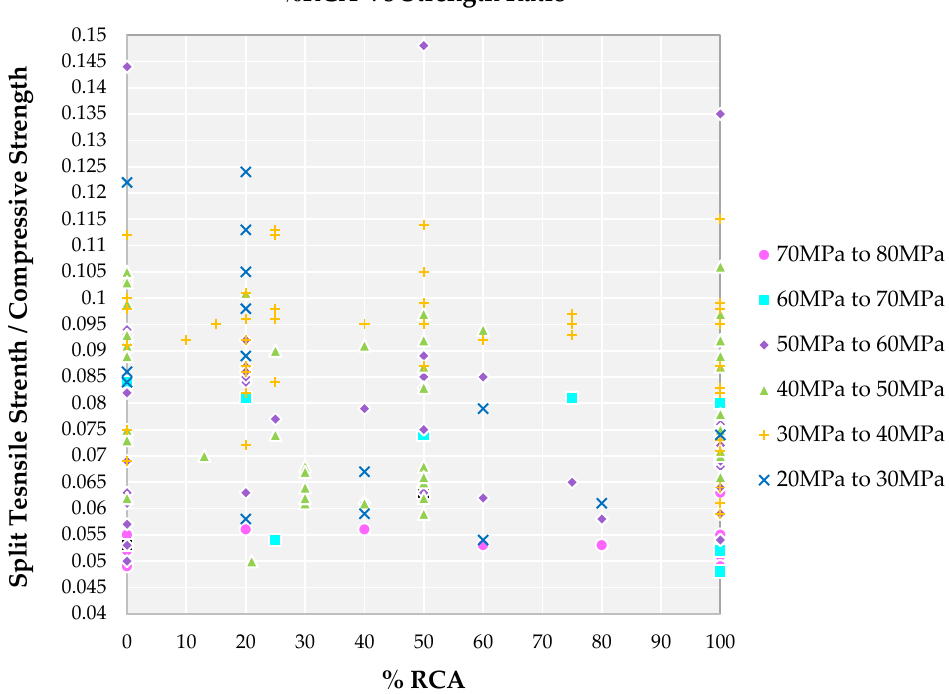
Figure 11. Impact of the percentage of RCA on various compressive strength of SCC concrete with recycled aggregate according to literature.